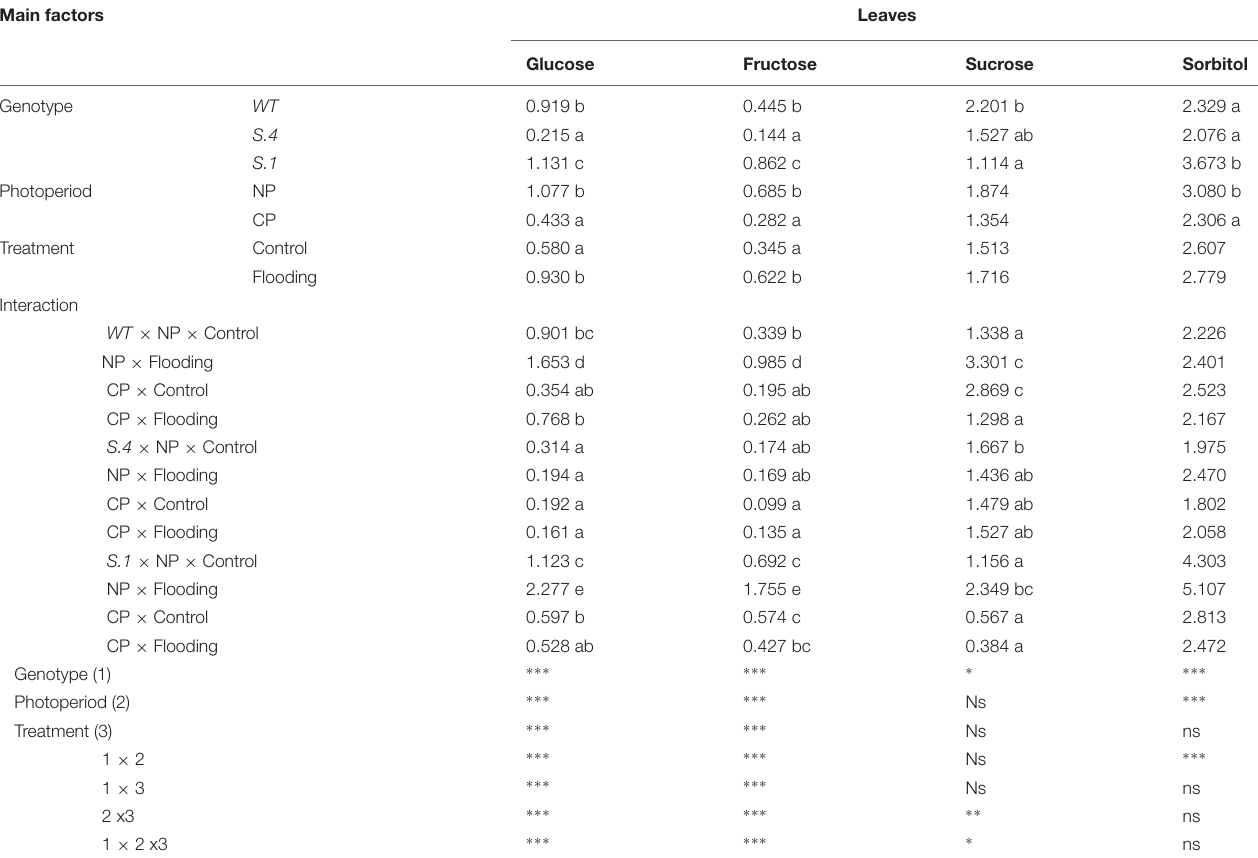
TABLE 3 | (A) Carbohydrates detected in leaves of S.1 , S.4, and WT plants, exposed to natural photoperiod (NP) and constant photoperiod (CP) after 14 days of flooding. Main